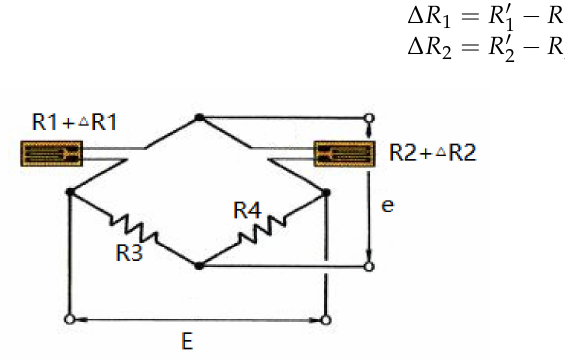
Figure 9. The connection circuit